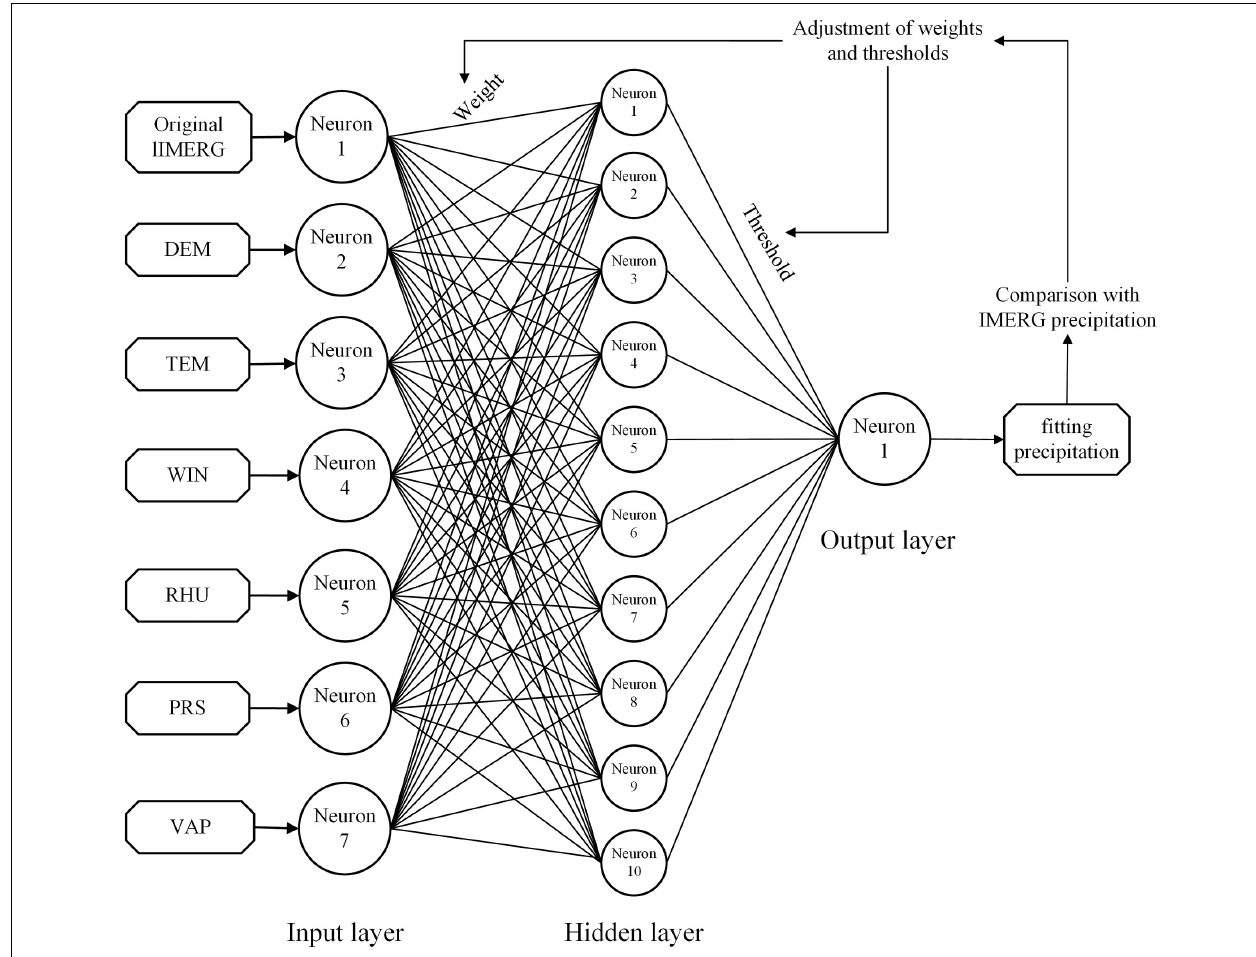
FIGURE 2 | The architecture of the BPNN